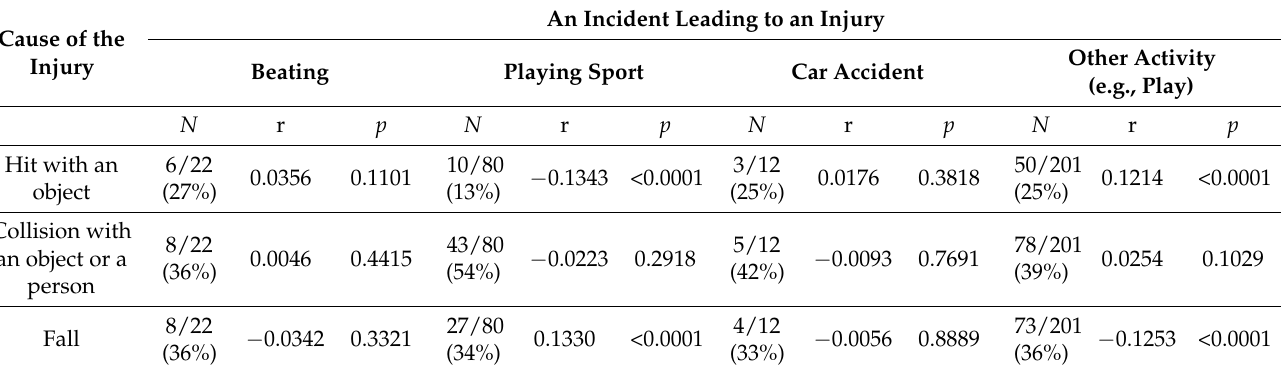
Table 4. Correlations between cause of injury and event (Spearman’s r-correlation